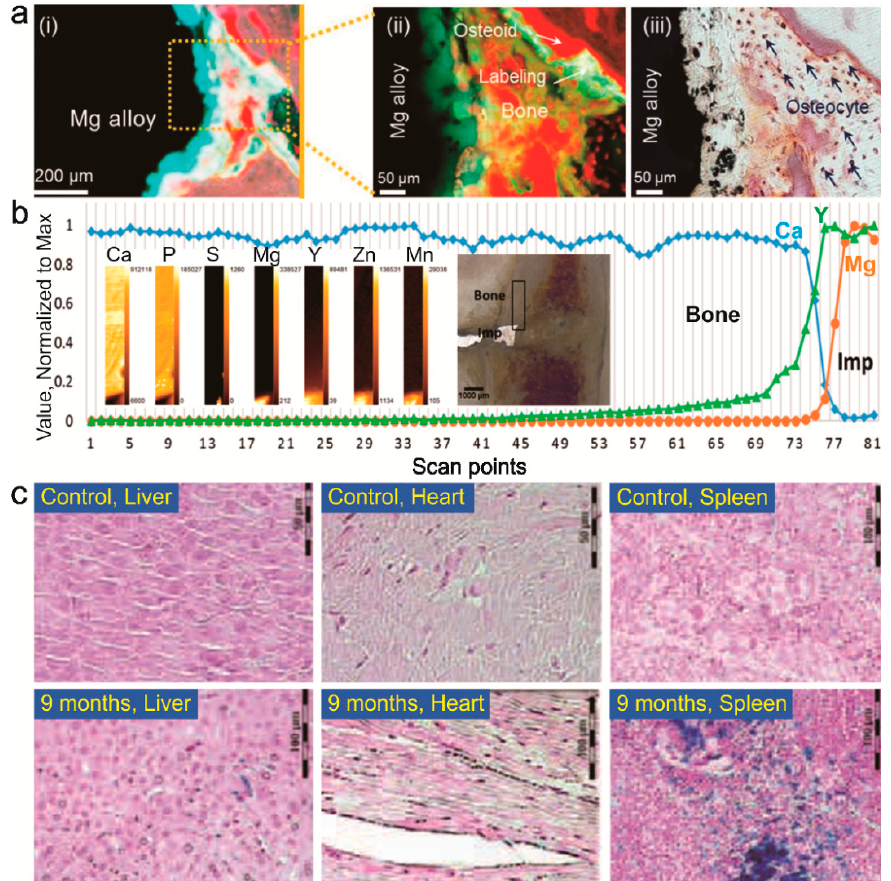
Figure 3. Example of local and systemic histological assessment of tissue-implant interaction: ( a ) fluorescence image of Villanueva stain on Mg alloy-contained femoral bone of New Zealand white rabbits after 26 weeks of implantation indicating a formation or differentiation of bone cells at the tissue-implant interface, which would not appear when using general stain of Hematoxillin-Eosine; ( b ) Micro X-ray Fluorescence (µXRF) elemental mapping of explanted WZ21 Mg alloy from femoral bone of a Sprague-Dawley rat after 12 months of implantation showing an elemental map that helps to understand the spreading of corrosion product in the vicinity of the implant; ( c ) Prussian blue stain image of liver, heart and spleen of mice after nine months of exposure to Fe stent implantation depicting corrosion product deposit in the organ of interest as a way of systemic evaluation of organs toxicity. Adapted with permission from John Wiley and Sons [55,56,58].